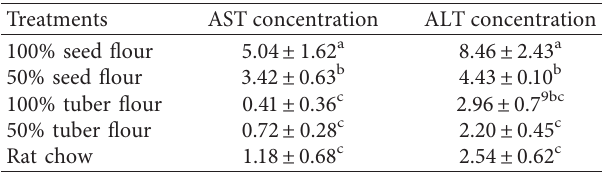
Table 1: Effect of AYB seed and tuber meal on Plasma AST and ALT levels in Wistar